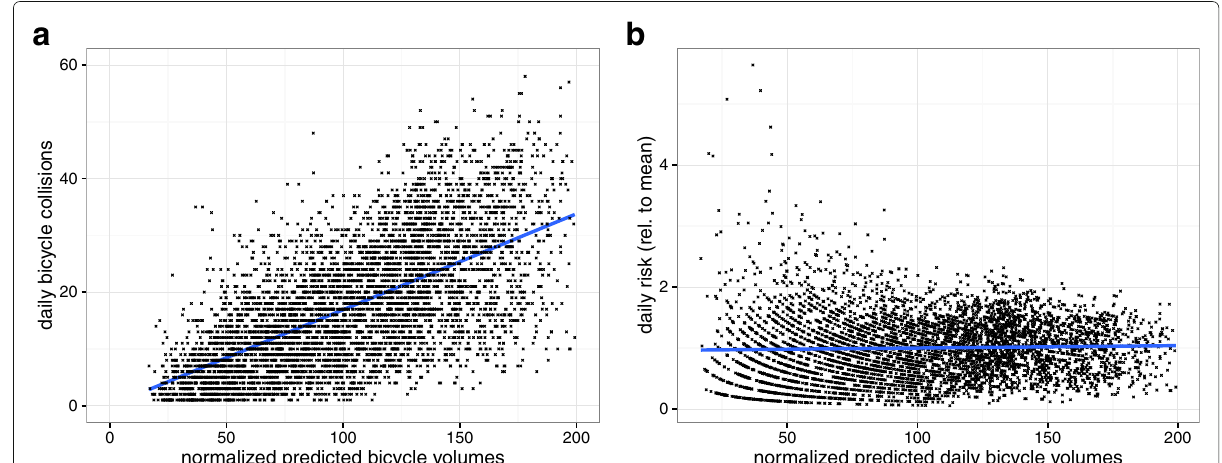
Fig. 7 Normalized, predicted daily bicycle volumes versus ( a ) the daily collisions involving bicyclists and motorised vehicles and ( b ) the corresponding daily